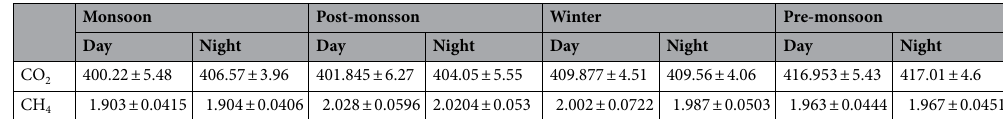
Monsoon Post-monsson Winter